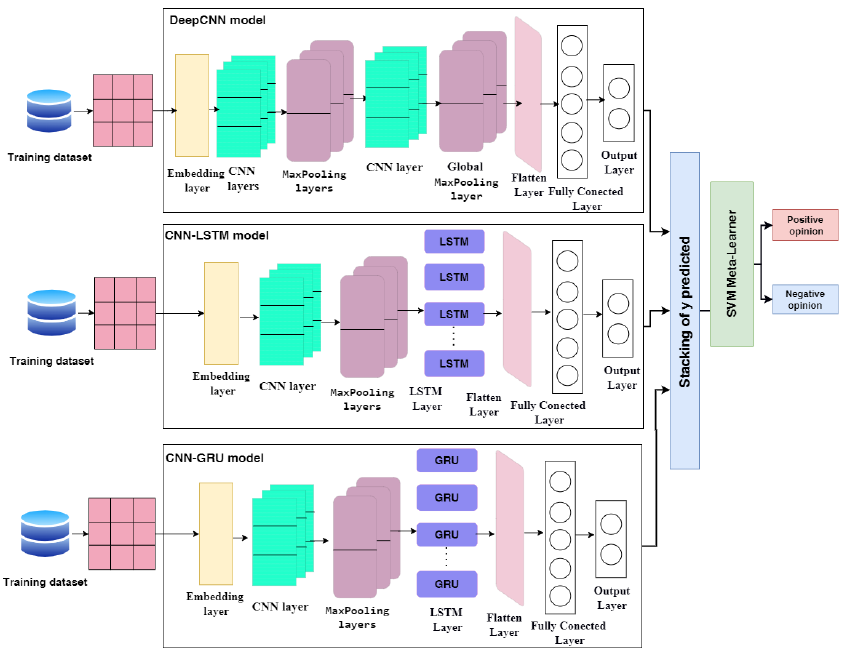
Figure 2. The architecture of the proposed ensemble